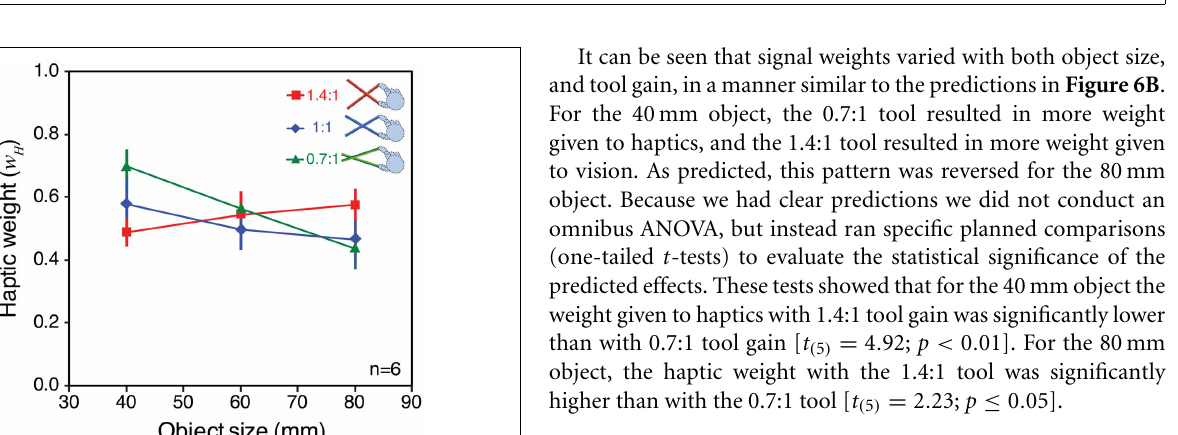
FIGURE 7 | Perceived size results from Experiment 2. Each panel shows perceived size as a function of variations in the visual object size, for each tool type, averaged across all participants. Panels (A–C) show the data for haptic object sizes of 40, 60, and 80mm, respectively. Error bars denote ± 1 standard error.